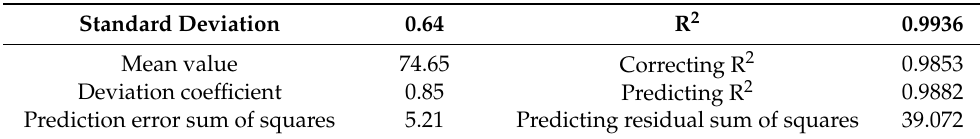
Table 7. Integrated evaluation of goodness of the recommended model in high-gradient magnetic separation tests.